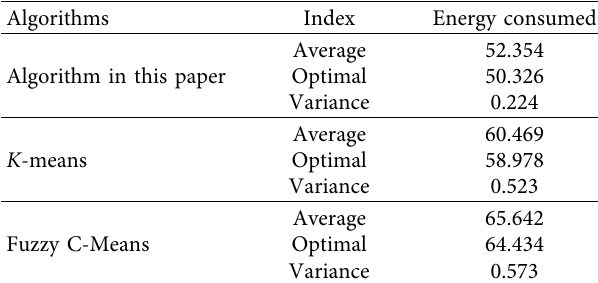
Figure 7: The relationship between energy consumption and the number of UAV of different algorithms. Table 2: The energy consumed by calculating the location of UAV by different